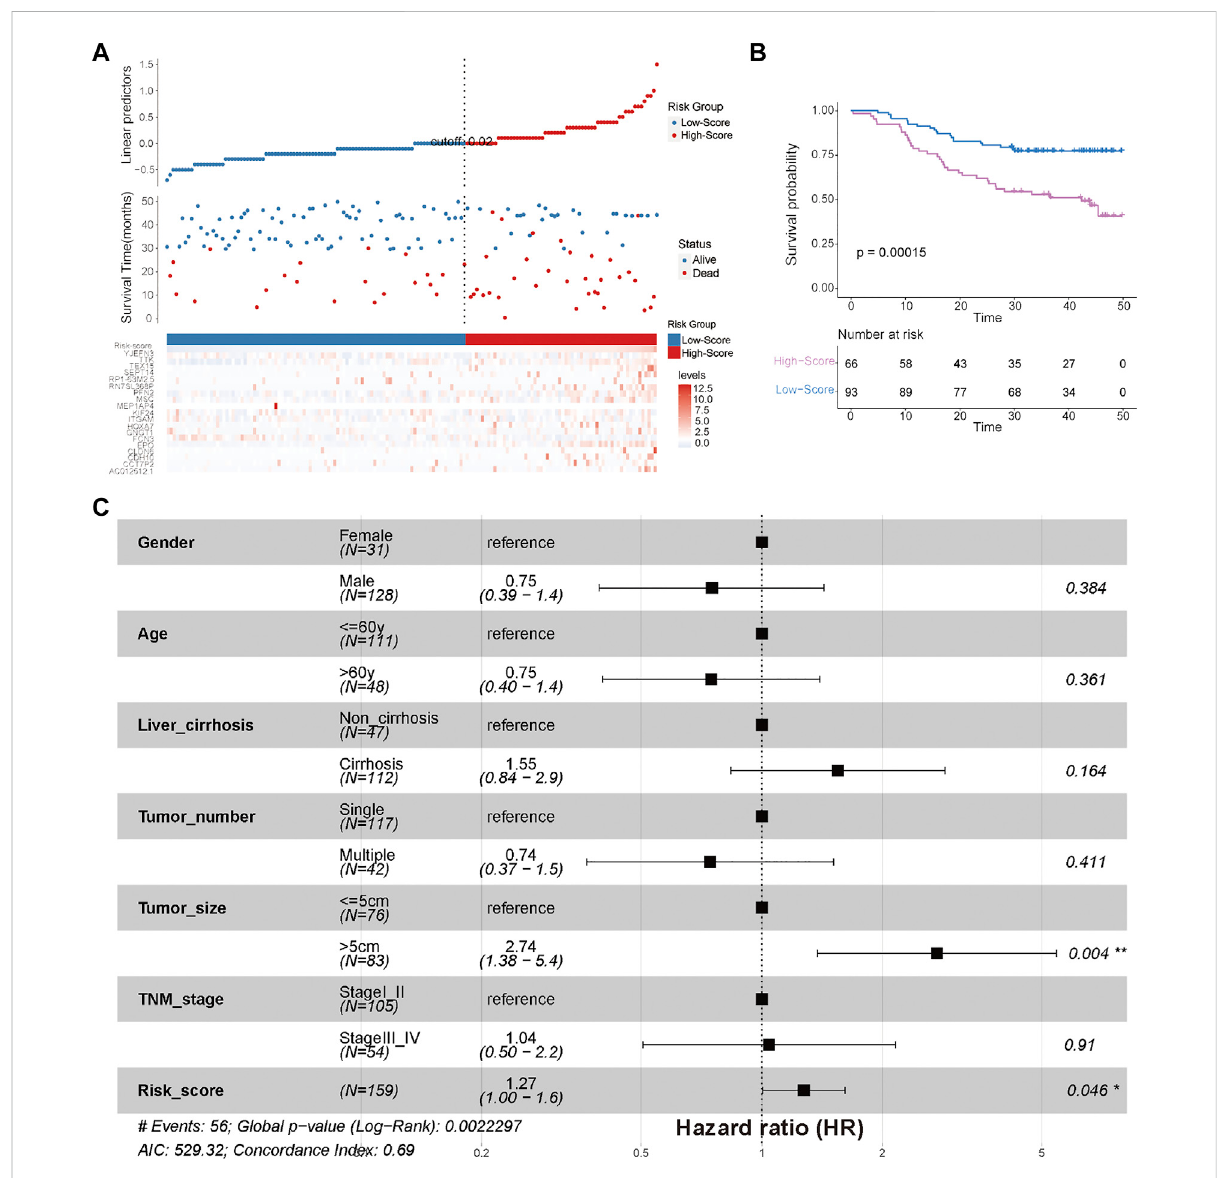
FIGURE 6 External validation of the ef fi ciency of the cuproptosis-related risk score in validation cohort 1 (China-HCC). (A) Survival status of HCC patients andexpressionofthe19signi fi cantprognosticDEGsinthehigh-andlow-scoregroups. (B) Kaplan – MeiercurveforthetworiskgroupsintheChina- HCC cohort. (C) Forest plot of clinicopathological features and risk scores in the China-HCC